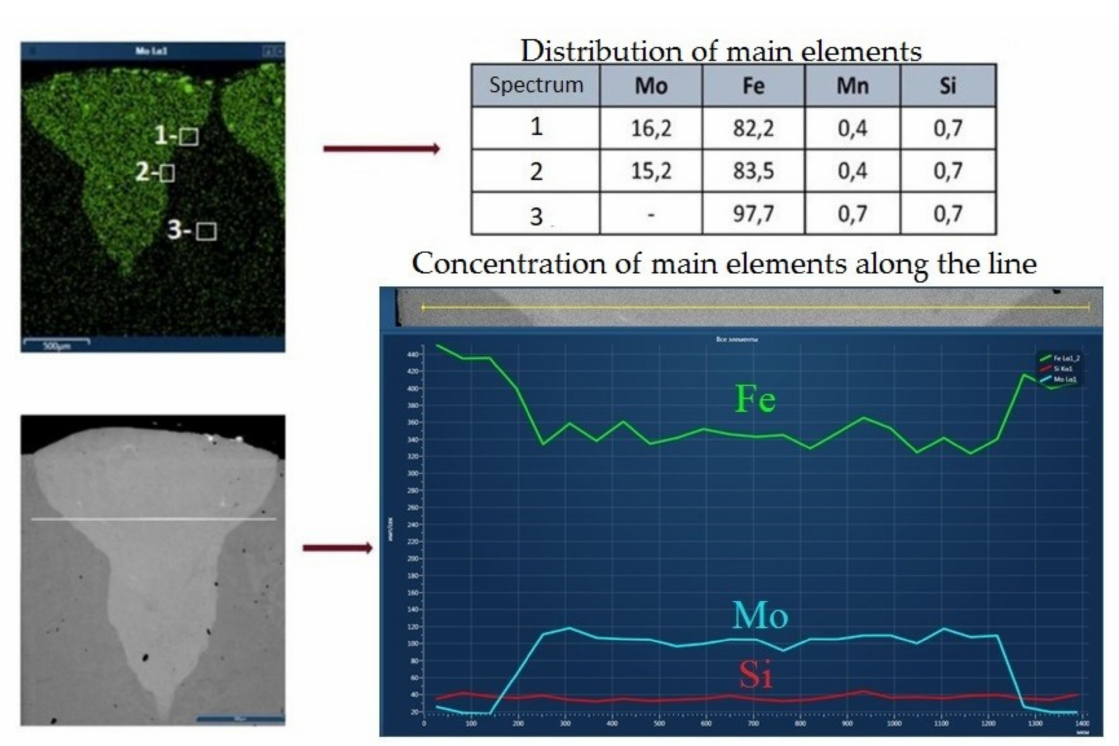
Figure 11. Distribution map and concentration of the main elements in the region of the boundary between the deposited material and the steel